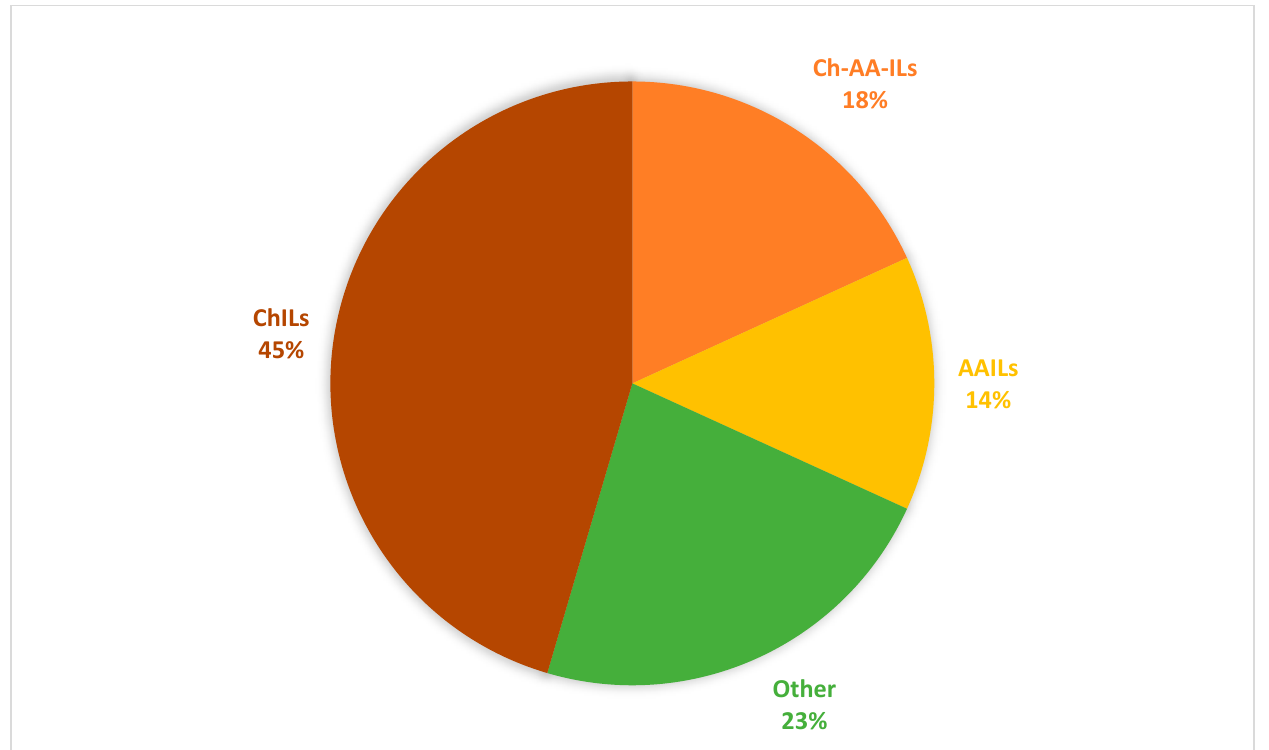
Figure 1. Classification of the Bio-ILs that are mentioned in the literature the period between 2020 and 2022 based on their composition. Choline-based ILs (ChILs), amino-acid-based ILs (AAILs) and choline-amino acid ILs